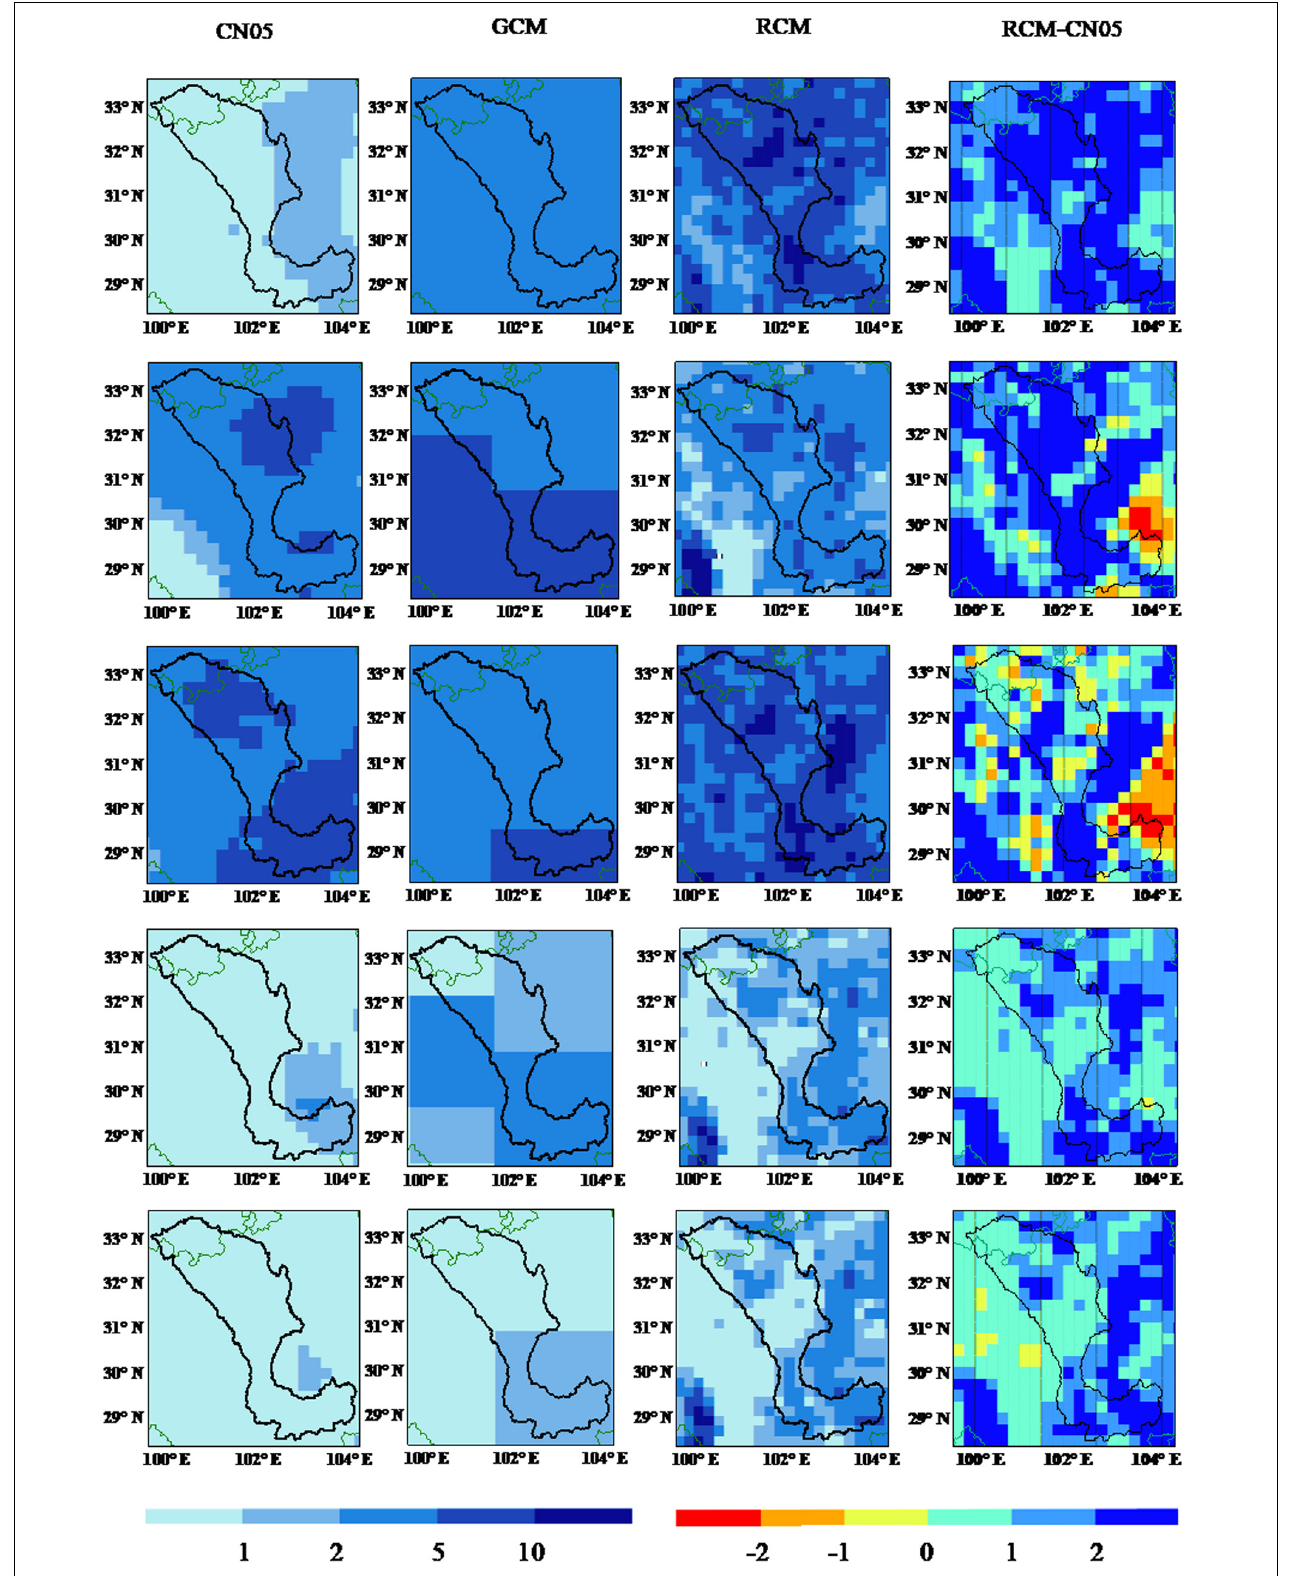
FIGURE 5 | Simulation results and deviation of difference scale models in each period.